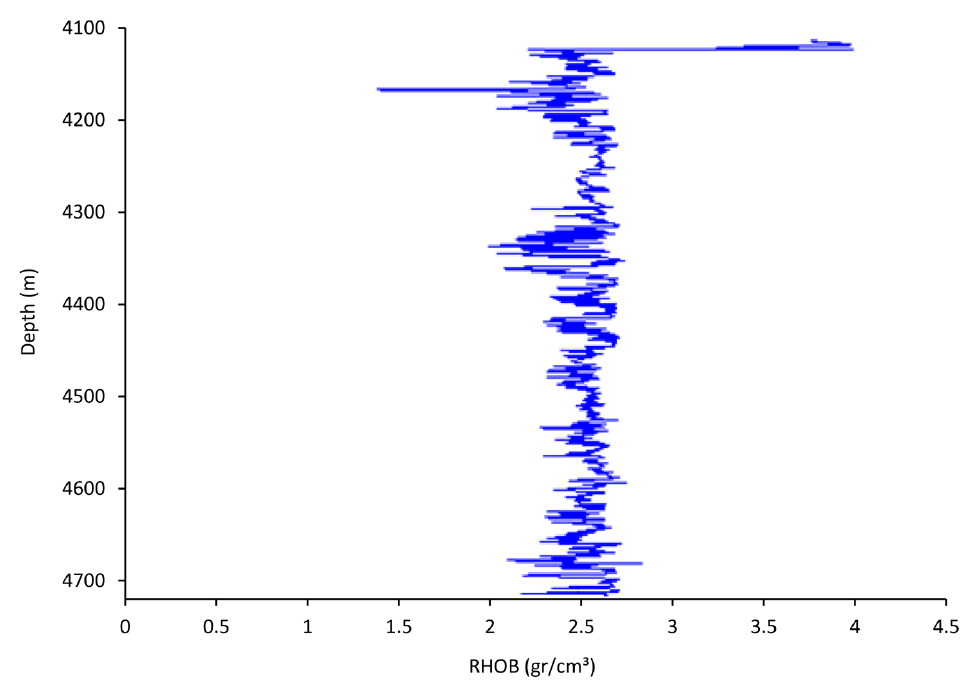
Figure 3. Variations of bulk density (gr/cm 3 ) vs. the depth (m) of wellbore-D in the Azar oilfield.